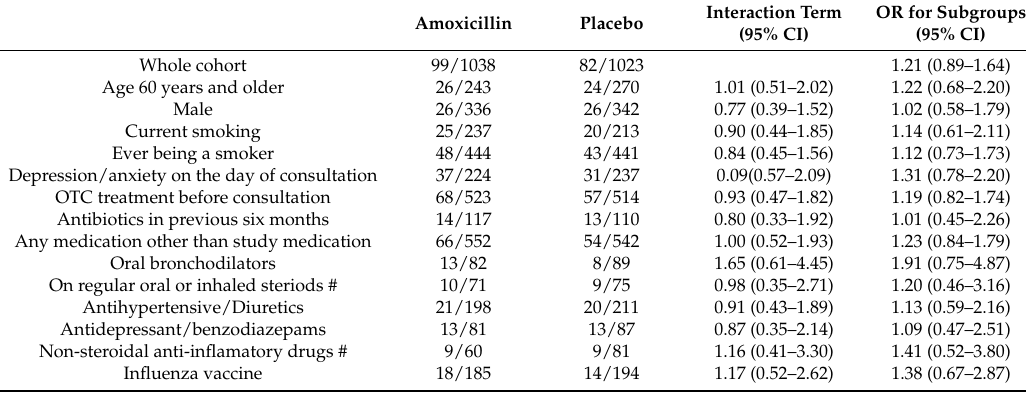
Table 3. Nausea in the whole cohort and in subgroups of adult patients in the first week after presenting to primary care with a LRTI and allocation to amoxicillin or placebo.